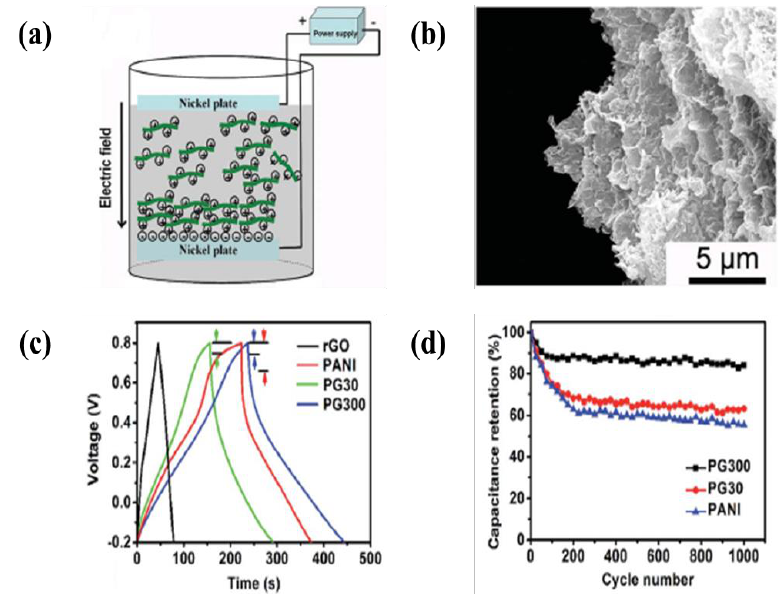
Figure 22. ( a ) Sketch of the electrophoretic deposition for the preparation of the layered polyaniline/graphene electrode; ( b ) SEM image of the fracture surface of the layered polyaniline/graphene hybrid electrode prepared by EPD; ( c ) Galvanostatic charge/discharge curves at a current density of 0.5 A g −1 ; ( d ) Cycle stability at a current density of 2 A g −1